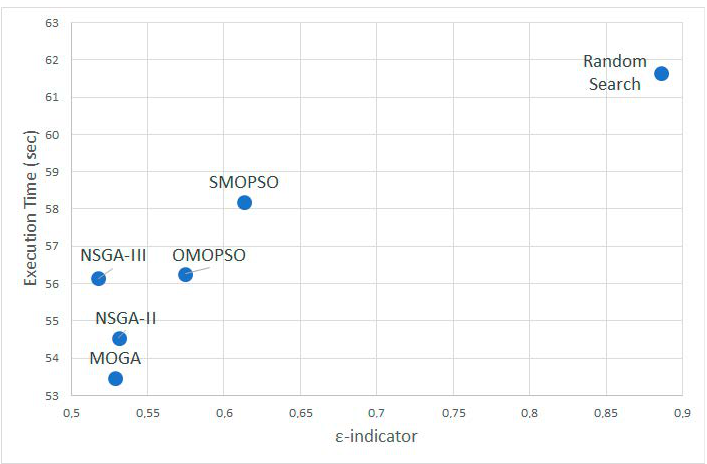
Figure 16. Plot chart mapping the studied algorithms according to the ET and the ε -Indicator.